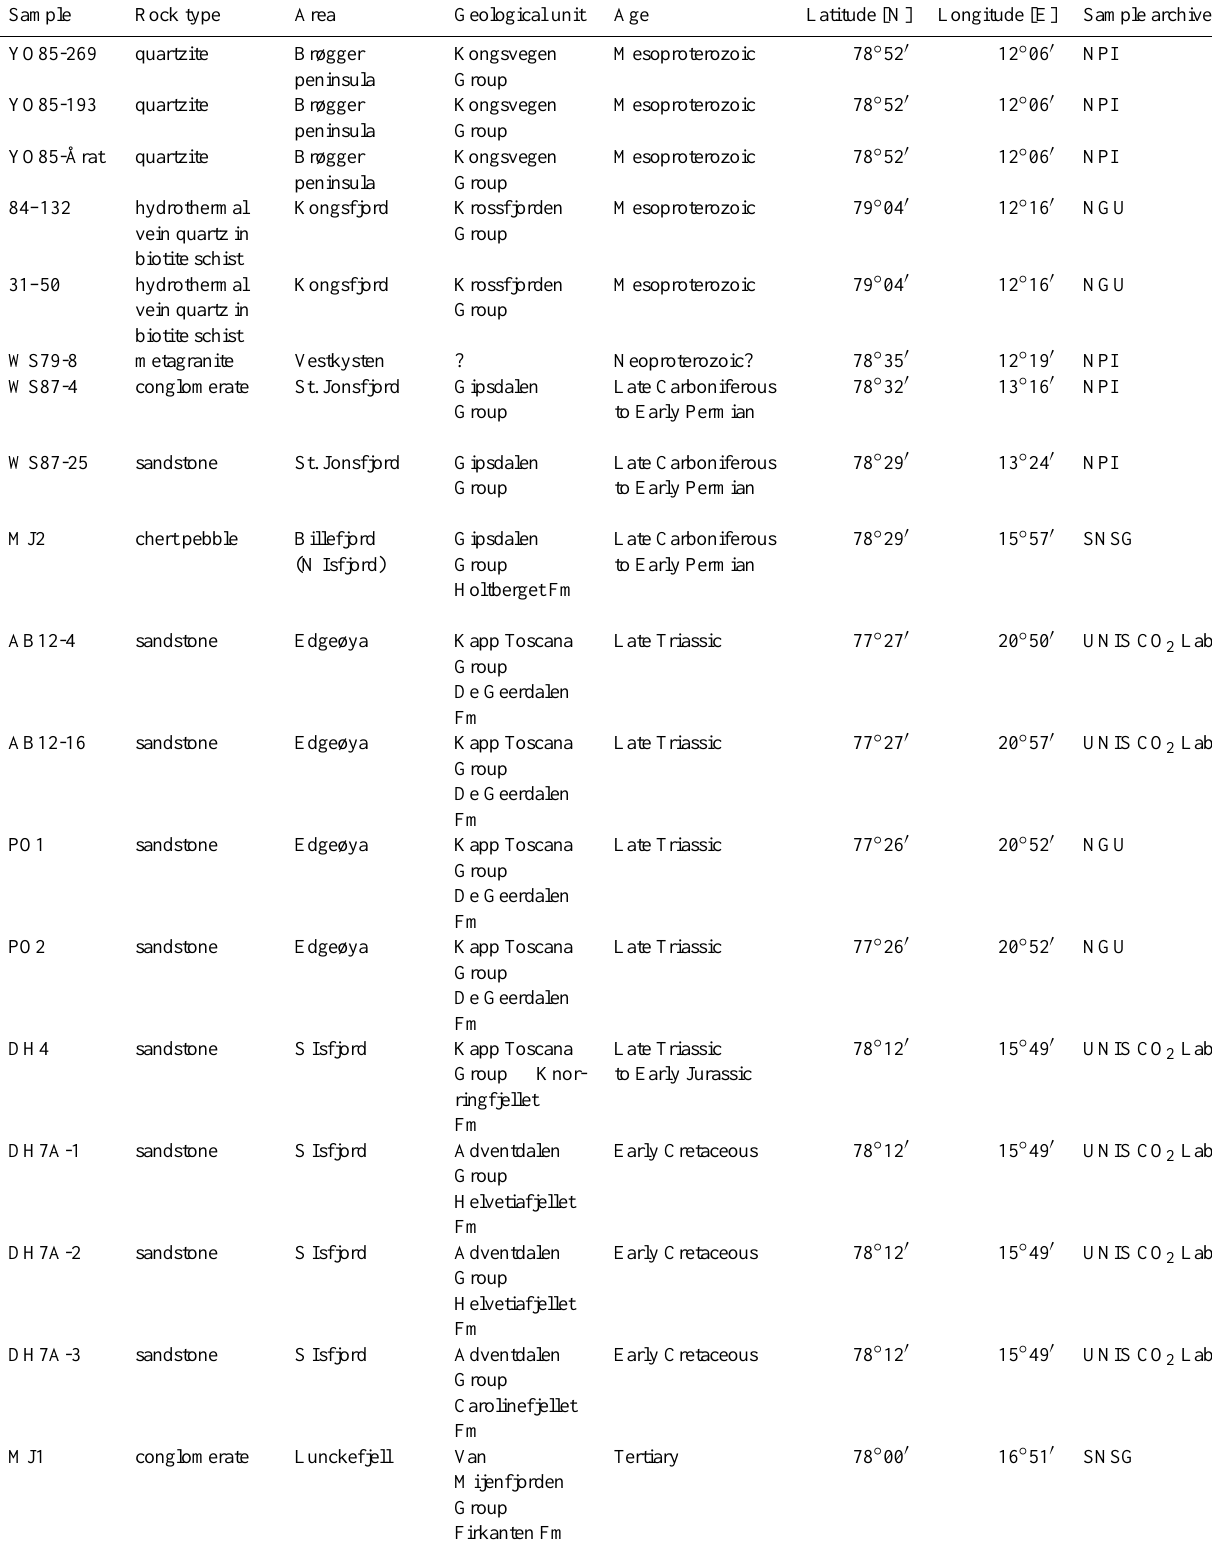
Table 2. Origin and type of investigated onshore samples for comparative studies. NGU – Geological Survey of Norway in Trondheim, NPI – Norwegian Polar Institute in Tromsø, SNSG – Store Norske Spitsbergen Grubekompani AS, UNIS CO 2 Lab – University Centre in Svalbard CO 2 Lab AS, Fm –